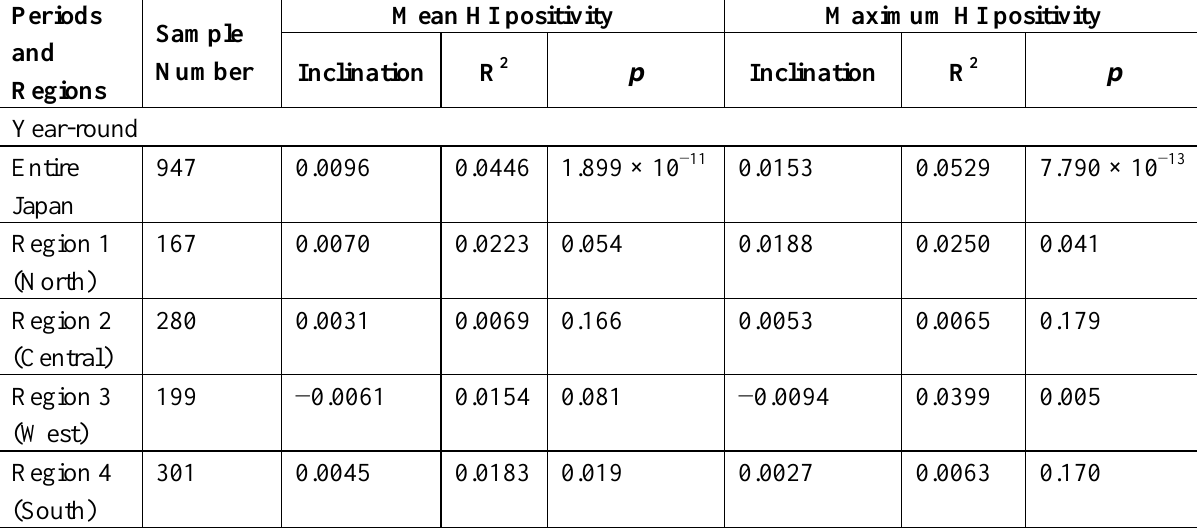
Table 1. Relationship between the annual and summertime precipitation and sero-conversion rate to JE virus in sentinel